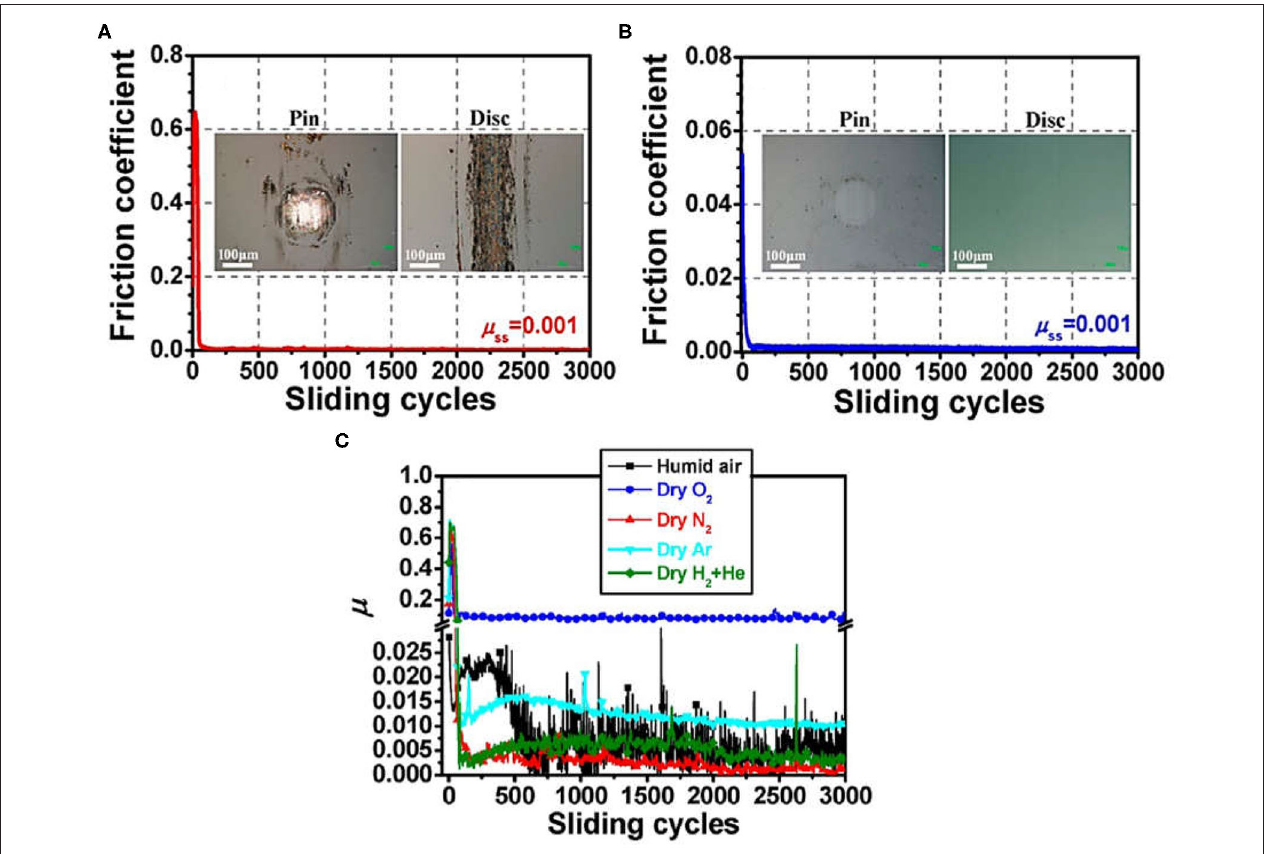
FIGURE 4 | Contact area and extremely low friction coefficient of 0.001 achieved with a-C:H:Si (A) and (B) a-C:H. (C) Superlubricity achieved with a-C:H:Si in humid air, dry Ar, dry N 2, and Dry H 2 + He. Adapted with permission from Chen et al. (2014) Copyright 2014, American Chemical Society.